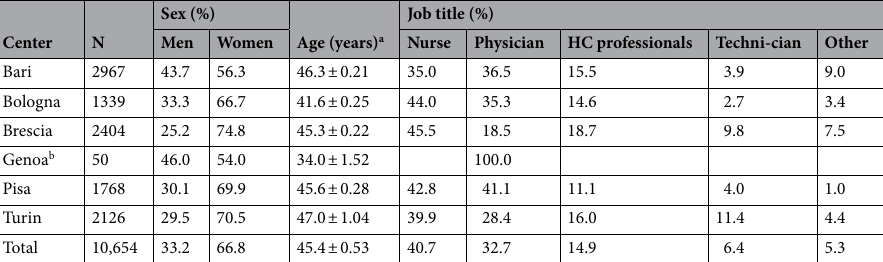
Table 2. Selected characteristics of study population. HC healthcare. a Mean ± standard deviation. b Medical school faculty and residents, among 881 HCWs under surveillance.